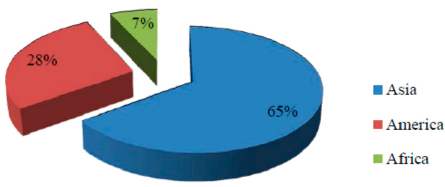
Figure 2. Percentage of bamboo produced by continent [21,30].